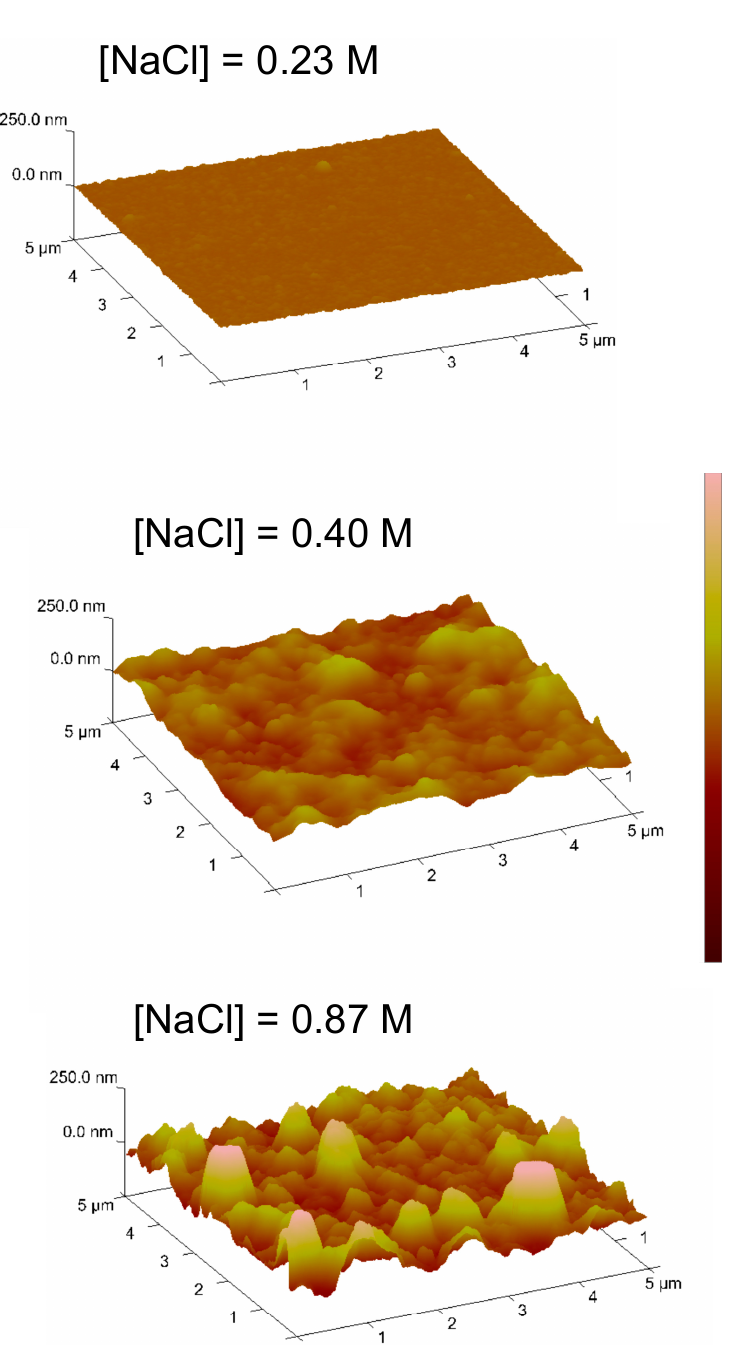
Figure 2. AFM images of surfaces after 9 h of polymerization and different NaCl concentrations in the polymerization medium.